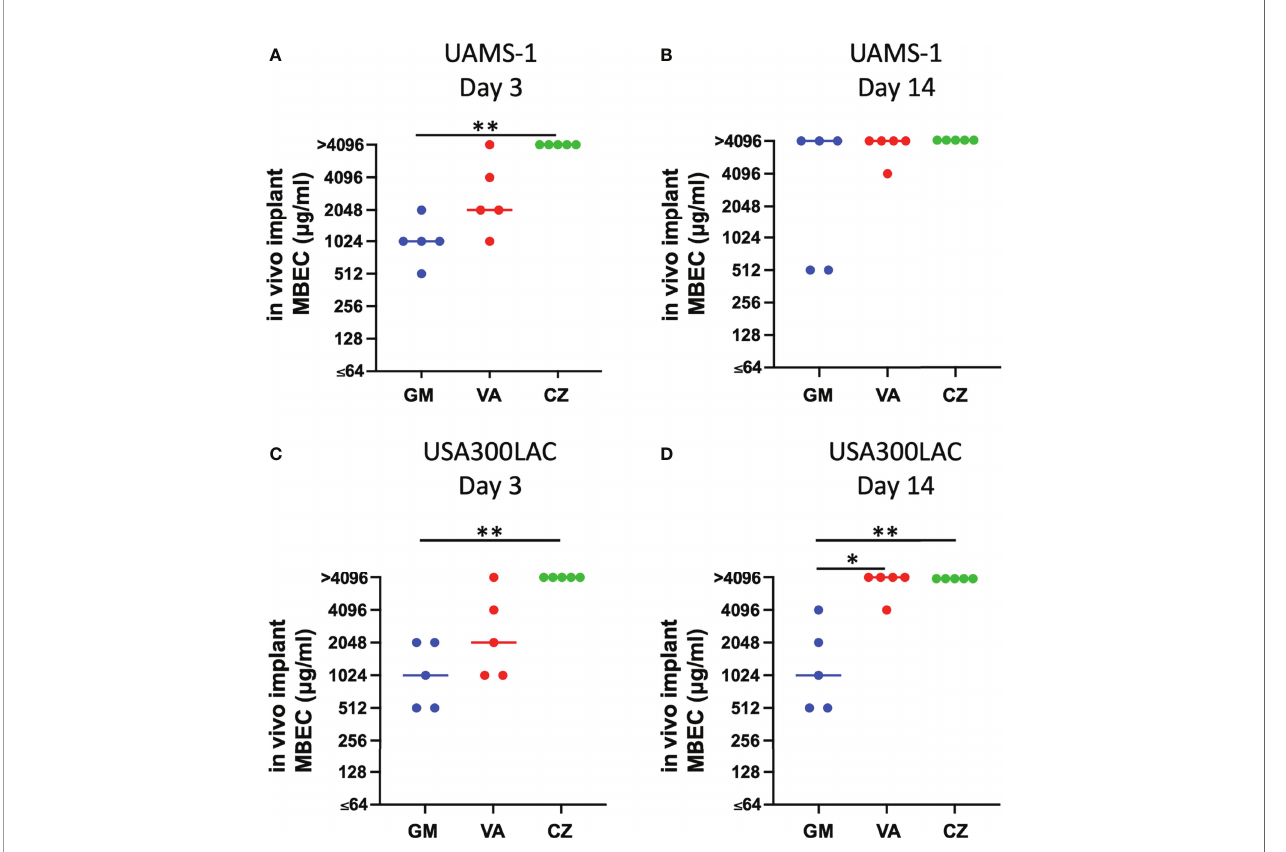
FIGURE 5 | Minimal bio fi lm eradication concentration against residual in vivo bio fi lm after vortex-sonication-vortex-method. ( in vivo implant MBEC) of UAMS-1 (A, B) and USA300LAC (C, D) . Bars in each graph indicate the median of fi ve assays. **: p < 0.01 and *: p < 0.05 by Kruskal – Wallis test with Dunn ’ s multiple comparison. GM, gentamicin; VA, vancomycin; CZ, cefazolin.